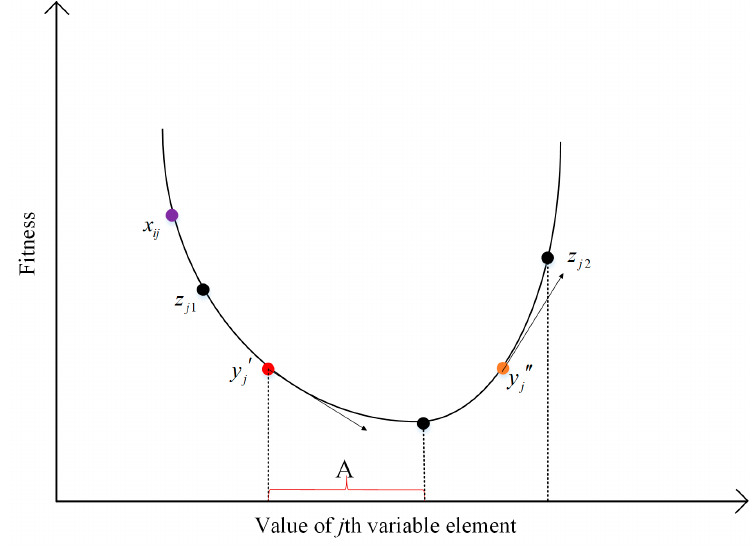
Figure 1. Optimization function curve near the global best solution.